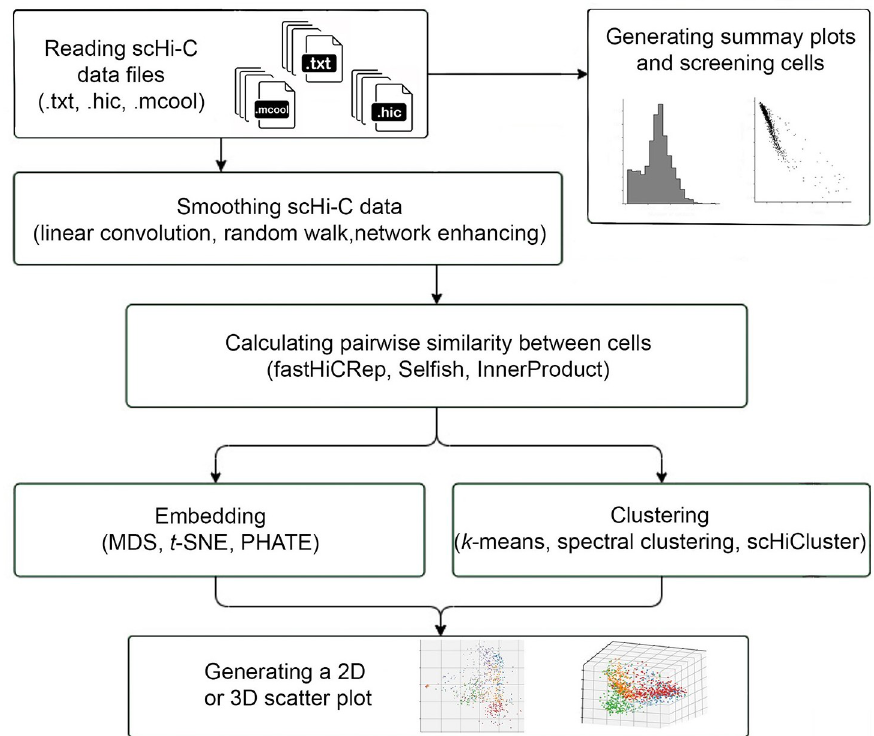
Fig 1. The workflow of scHiCTools. The workflow of scHiCTools includes five steps: (1) reading input single-cell data in .txt, .hic, or .cool format, generating the summary plots of the cells, and screening cells based on their contact number and contact distance profile, (2) smoothing the scHi-C contact maps using linear convolution, random walk, or network enhancing, (3) calculating the pairwise similarity between cells using fastHiCRep, InnerProduct, or Selfish, (4) embedding or clustering the cells in a low-dimensional Euclidean space using dimension reduction methods, and (5) visualizing the two-dimensional or three-dimensional embedding in a scatter plot.